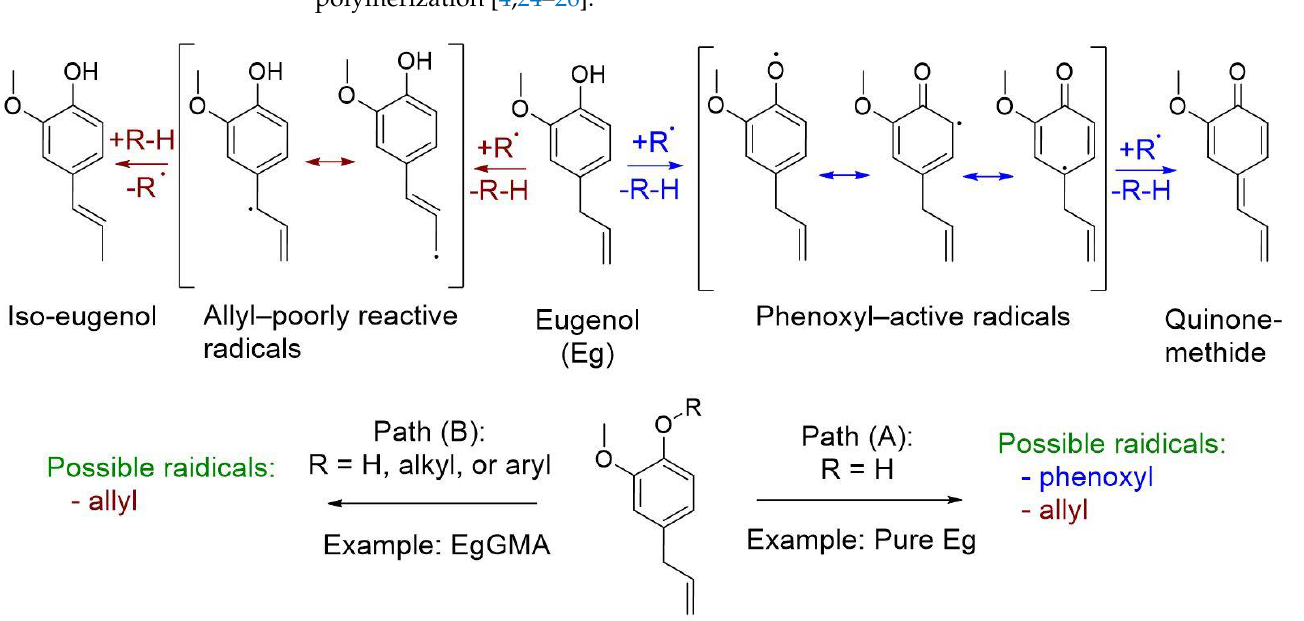
Figure 6. Phenoxyl and allyl radicals of eugenol and eugenol derivatives.